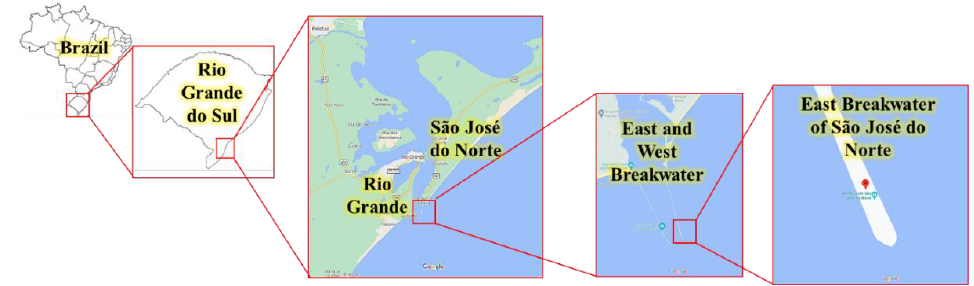
Figure 1. Location of the city of São José do Norte, RS, Brazil, and East Breakwater.